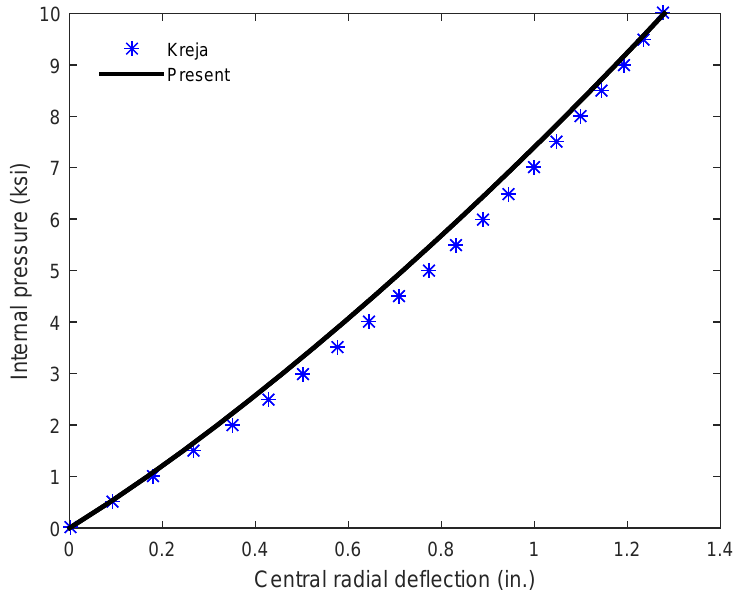
Figure 15. Central radial deflection of a fully clamped composite cylinder with L / R = 1, R / h =